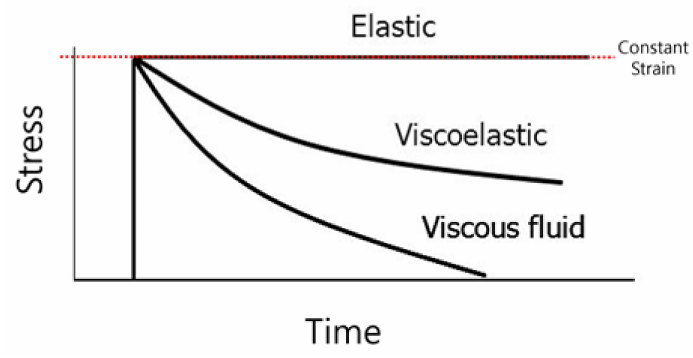
Figure 1. Stress relaxation curves of elastomer